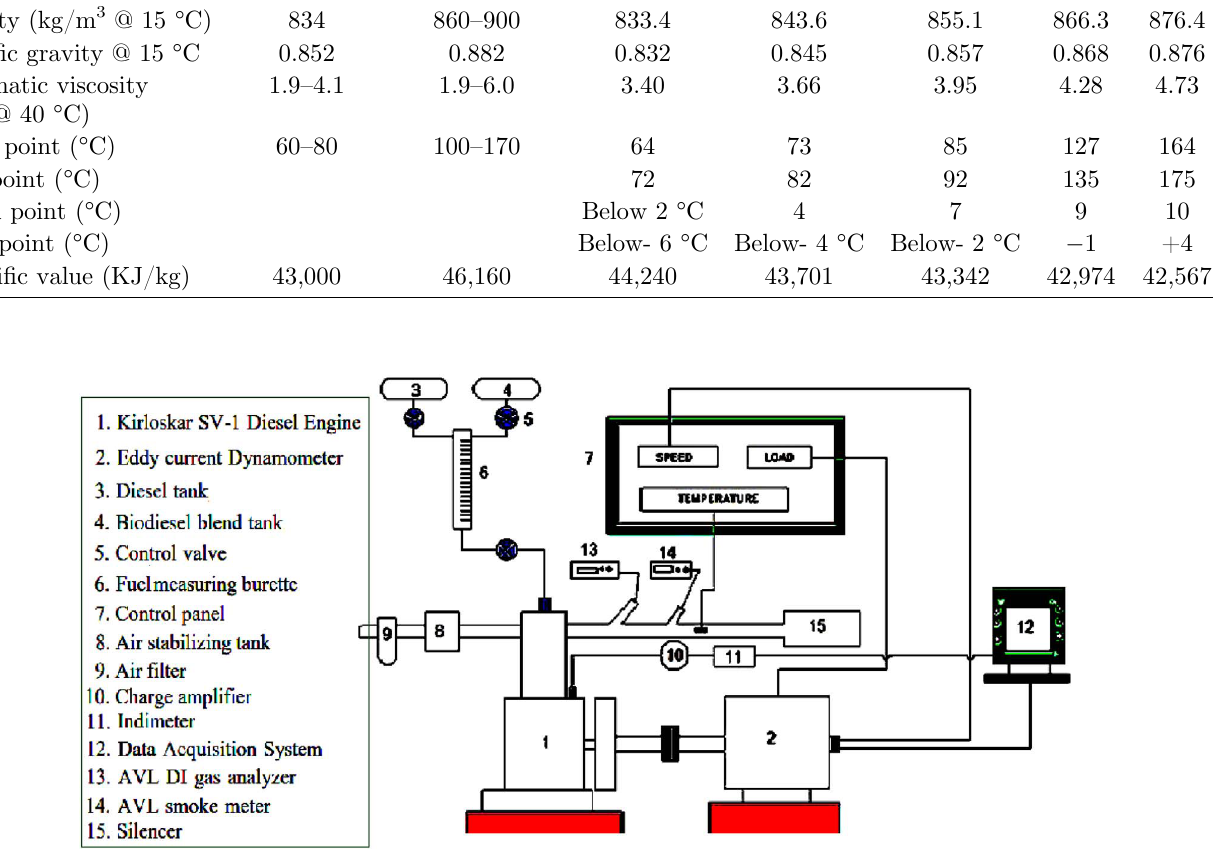
Figure 2. Schematic diagram of the experimental setup.